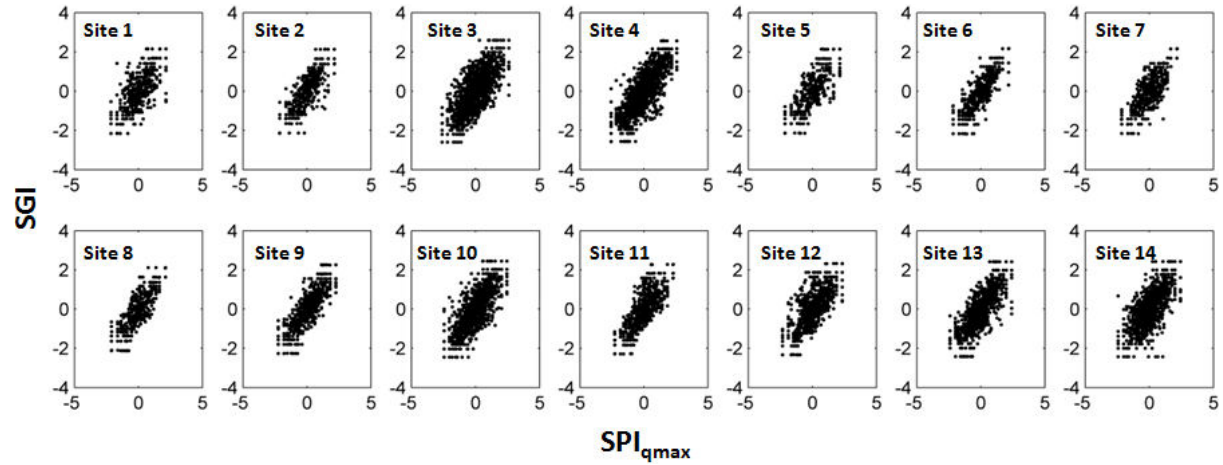
Fig. 9. SGI as a function of SPI q max for each site. The plots are for sites listed in Table 1 in alphabetical order from top left to bottom right.